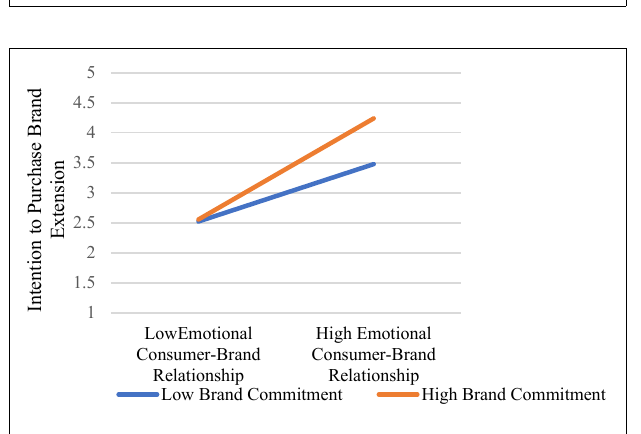
FIGURE 5 | Moderating effects of